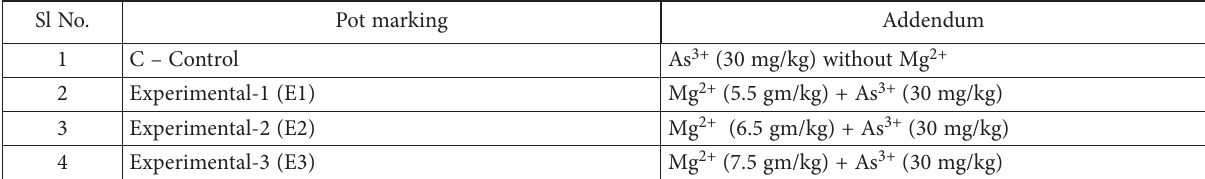
Table 1. Showing experimental set-up: pots with different addendum Sl